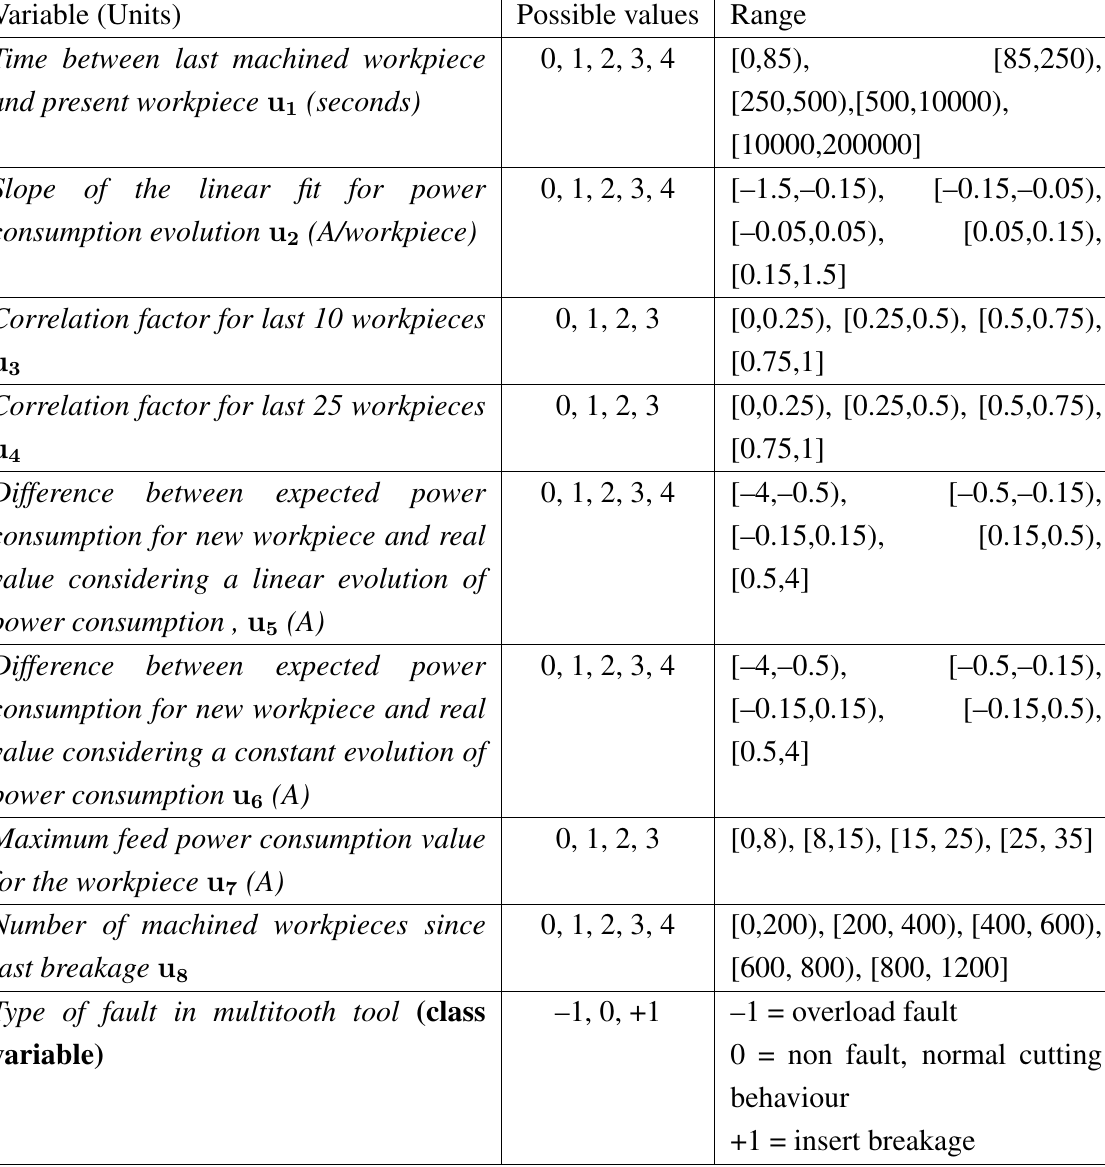
Table 1. Variables, units, values and discretization